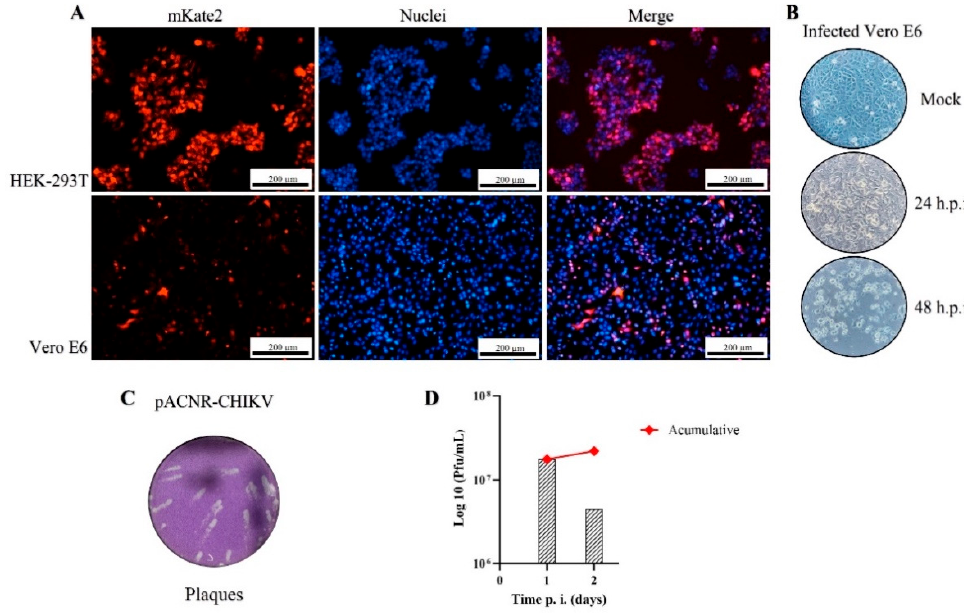
Figure 2. The Chikungunya virus plasmid pACNR-CHIKV produces a viral infection. ( A ) HEK-293T and Vero E6 cells infected with the supernatant of the producer (transfected) cells in fluorescent-field mKate2 expression (Texas Red filter), nuclei stain (DAPI filter), and merge at MOI of 1 for 24 h.p.i. ( B ) Cytopathic effects induced by the CHIKV infection in Vero E6 cells at MOI of 1. ( C ) CHIKV plaques on Vero E6 cells stained with crystal violet and ( D ) and virus titer measured as plaque-forming units (PFUs). Bar, 200 µm.